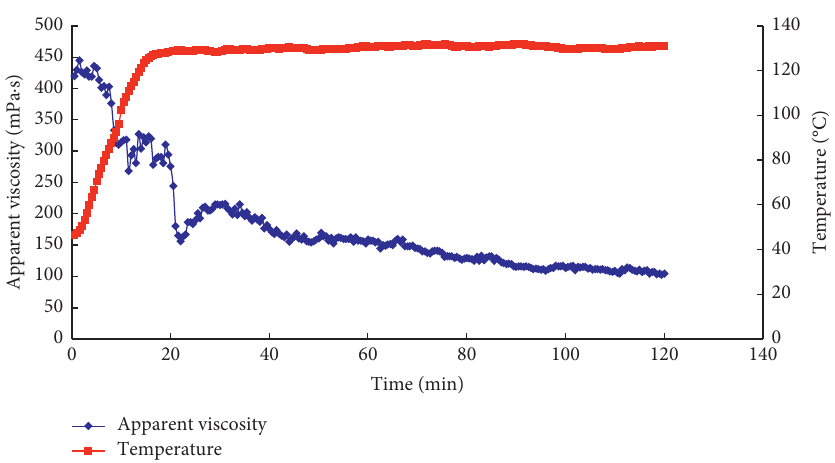
Figure 5: Temperature and shear resistance of the conventional density fracturing fluid of formula 1.